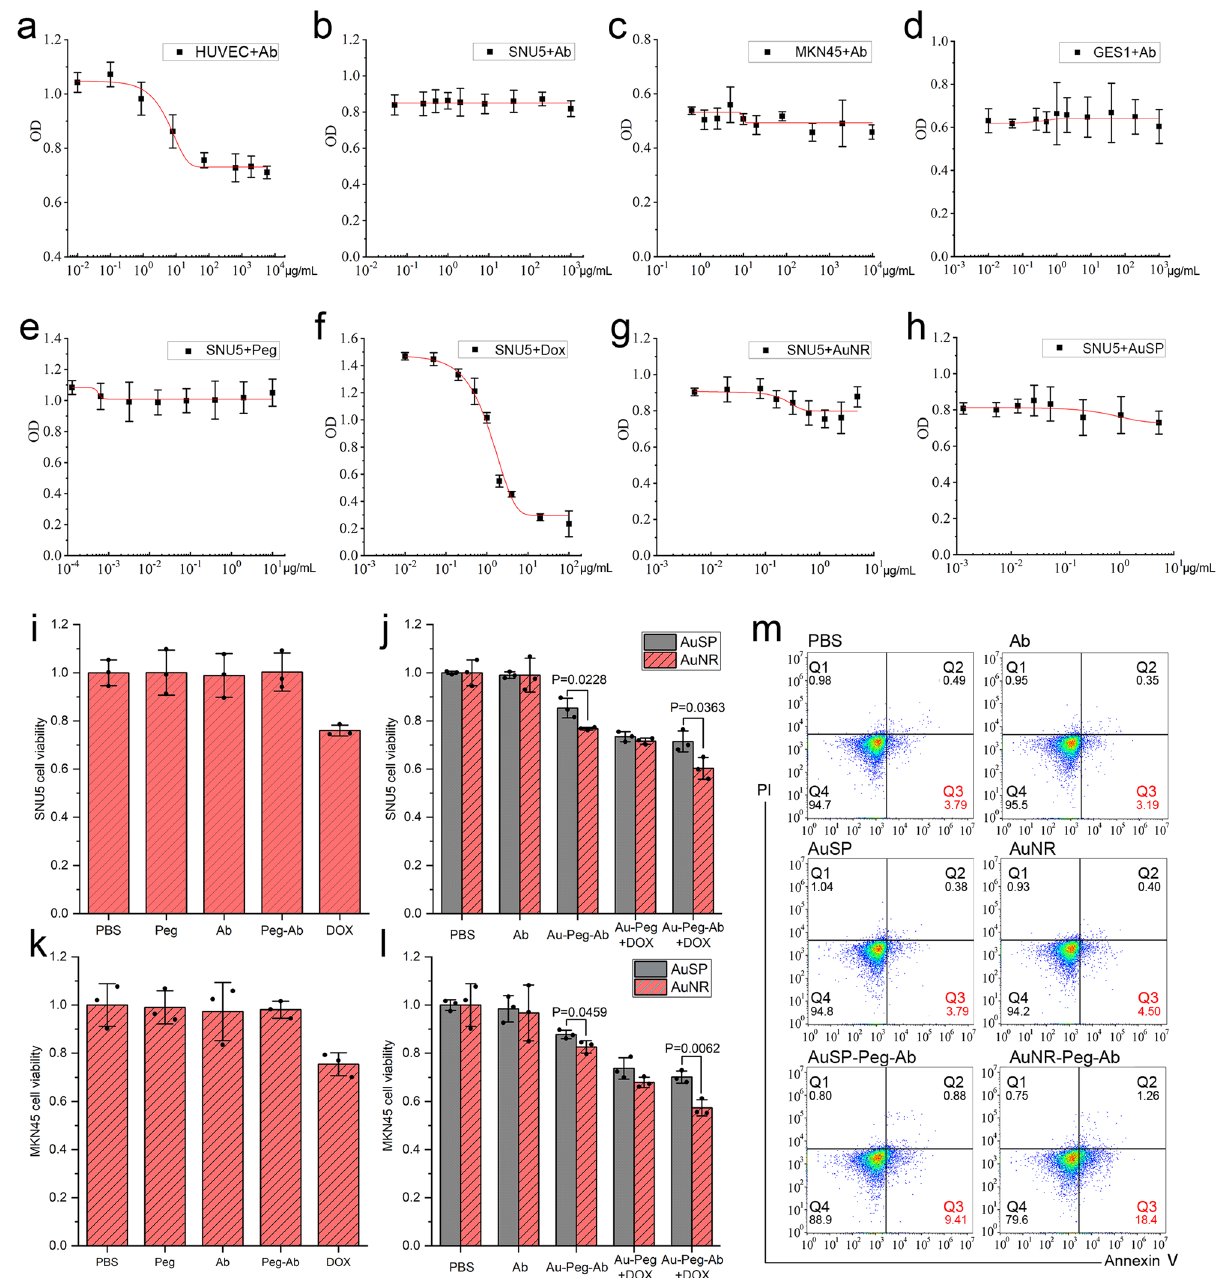
Fig. 4 Cytotoxicity tests in different cells. a – d IC 50 curve treatment by Ramucirumab (Ab) in HUVEC cells ( a ), SNU5 cells ( b ), MKN-45 cells ( c ), and GES-1cells ( d ). e – h IC 50 curve treatment by PEG ( e ), doxorubicin (DOX) ( f ), AuNR ( g ) and AuSP ( h ) in SNU5 cells. i – j MTT measurements of cell viability in SNU5 cells treated with different components. k , l MTT measurements of cell viability in MKN-45 cells treated with different components. m Cell apoptosis analysis by fl ow cytometry. Data represent mean ± SD ( n = 3). Statistical difference was evaluated by unpaired, two-tailed independent Student t